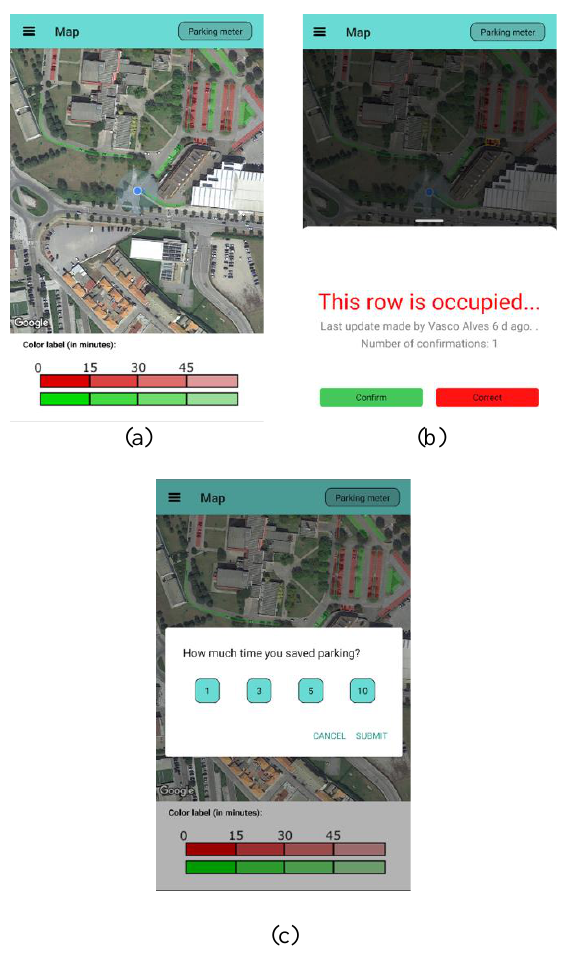
Figure 4. Map's Main Features: (a) Map Page; (b) Modal; (c) Pop-up for Data Purposes